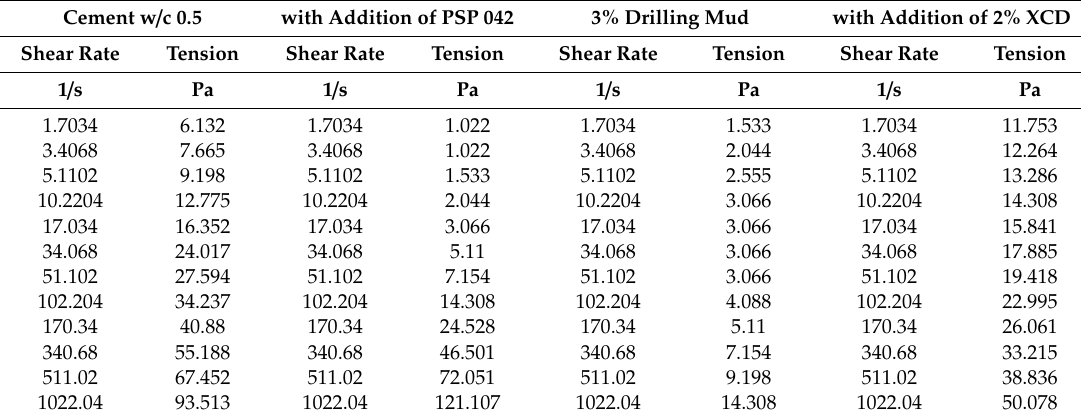
Table 2. Relations between shear stresses and shear rates obtained from laboratory tests on a Fann viscometer (R1-B1, F1). Cement w / c 0.5 3% Drilling Mud with Addition of 2% XCD Shear Rate